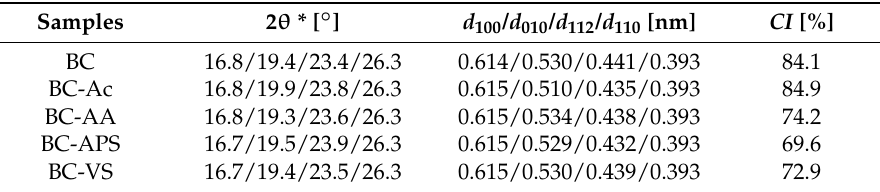
Table 1. XRD data for untreated and treated BC.